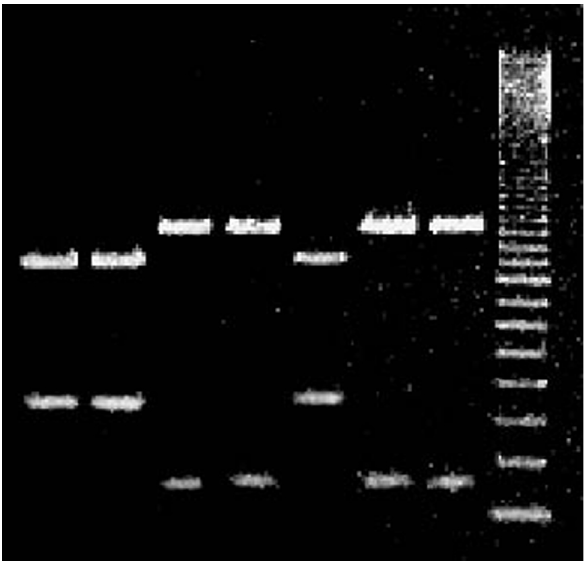
Figure 2 - Band pattern generated by HaeIII- P. lineatus (3,4,6 and 7) and P. recifinus (1, 2 and